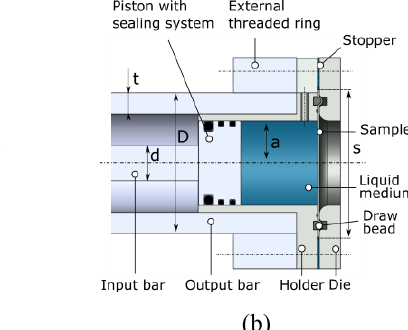
Fig. 1. Split Hopkinson bar bulge setup installed at Ghent University (a) and schematic representation components hydraulic chamber (b) (d=25mm, D=100mm, t=15mm, a=30mm,